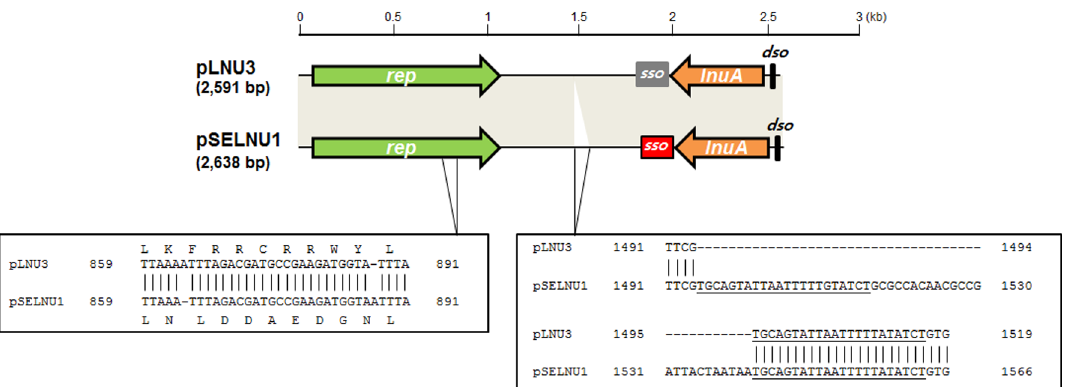
Fig 1. Gene structures of pLNU3 and pSELNU1. Shaded boxes correspond to sequences that exhibit 99% nucleotide sequence identity between pLNU3 and pSELNU1. Major sequence differences between both plasmids are identified as empty boxes. Amino acid changes in the Rep protein between both plasmids are also shown.